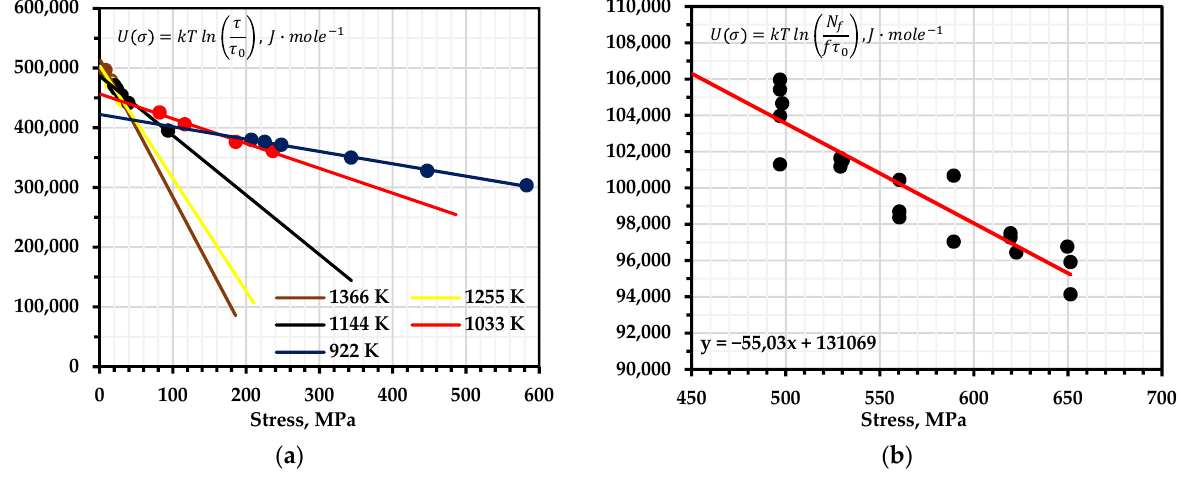
Figure 2. Graphical interpretation of the determination of the activation energy of the destruction of nickel alloy 625: ( a )—for creep processes; ( b )—for fatigue failure processes.